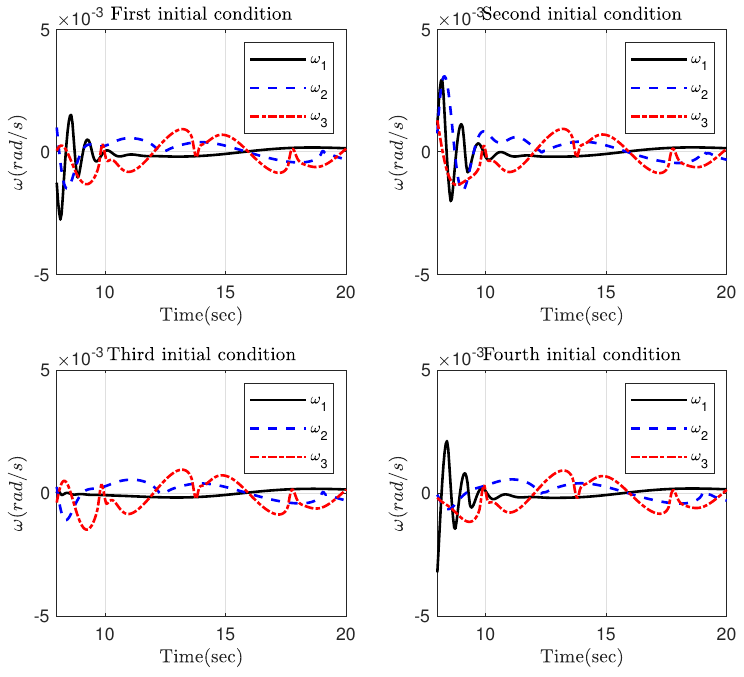
Figure 7. Steady state behavior of the rotation velocity in Part 1 for different initial